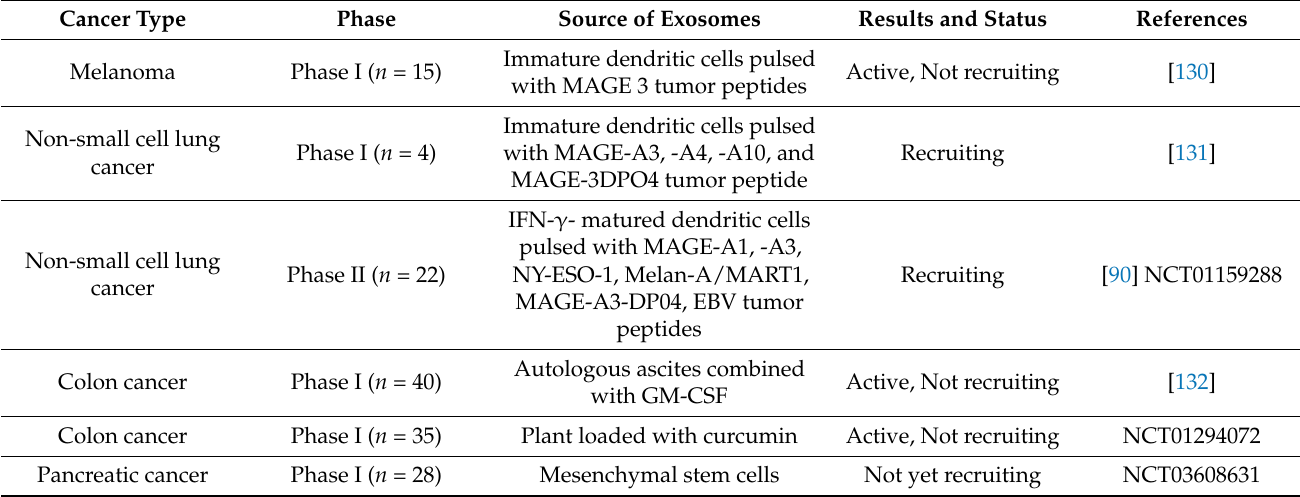
Table 3. Human clinical trials of exosomes in cancer